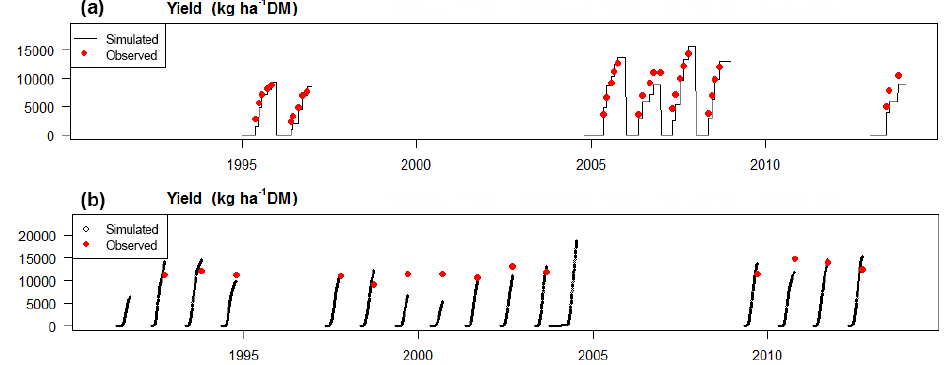
Figure 5. Results of case studies at location 1 (De Marke): observed yields (kgha − 1 DM) as red dots and simulated yields as black lines or as black dots: (a) for yields (kgha − 1 DM) of grassland; (b) for yields (kgha − 1 DM) of